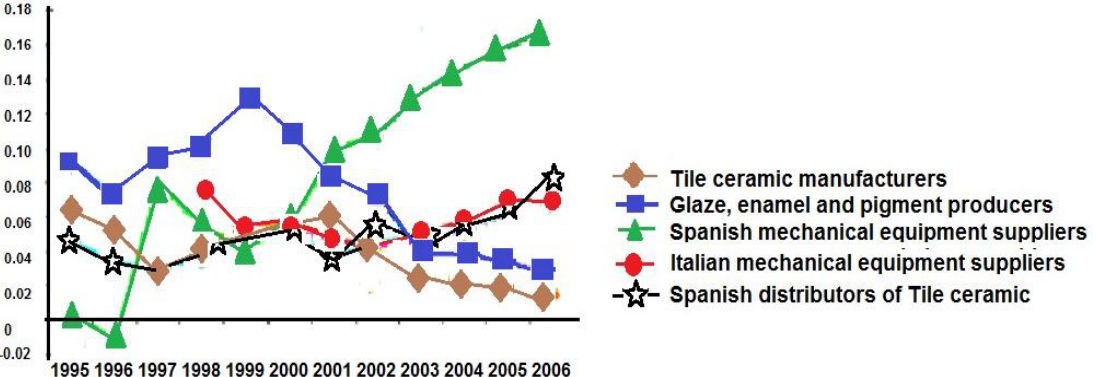
Figure 3. Return on assets (ROA).